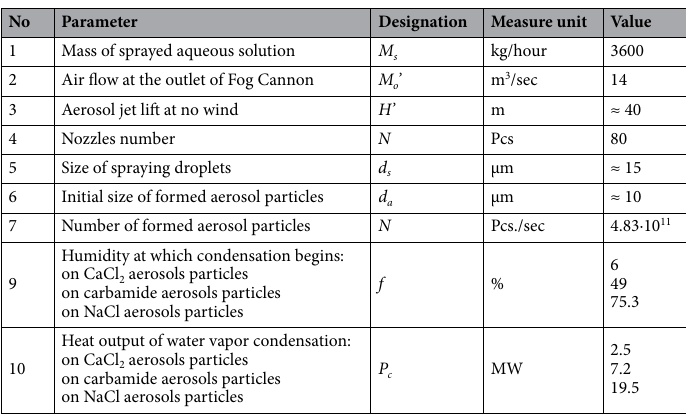
Table 2. Parameters of hygroscopic aerosol stream on the output of Fog